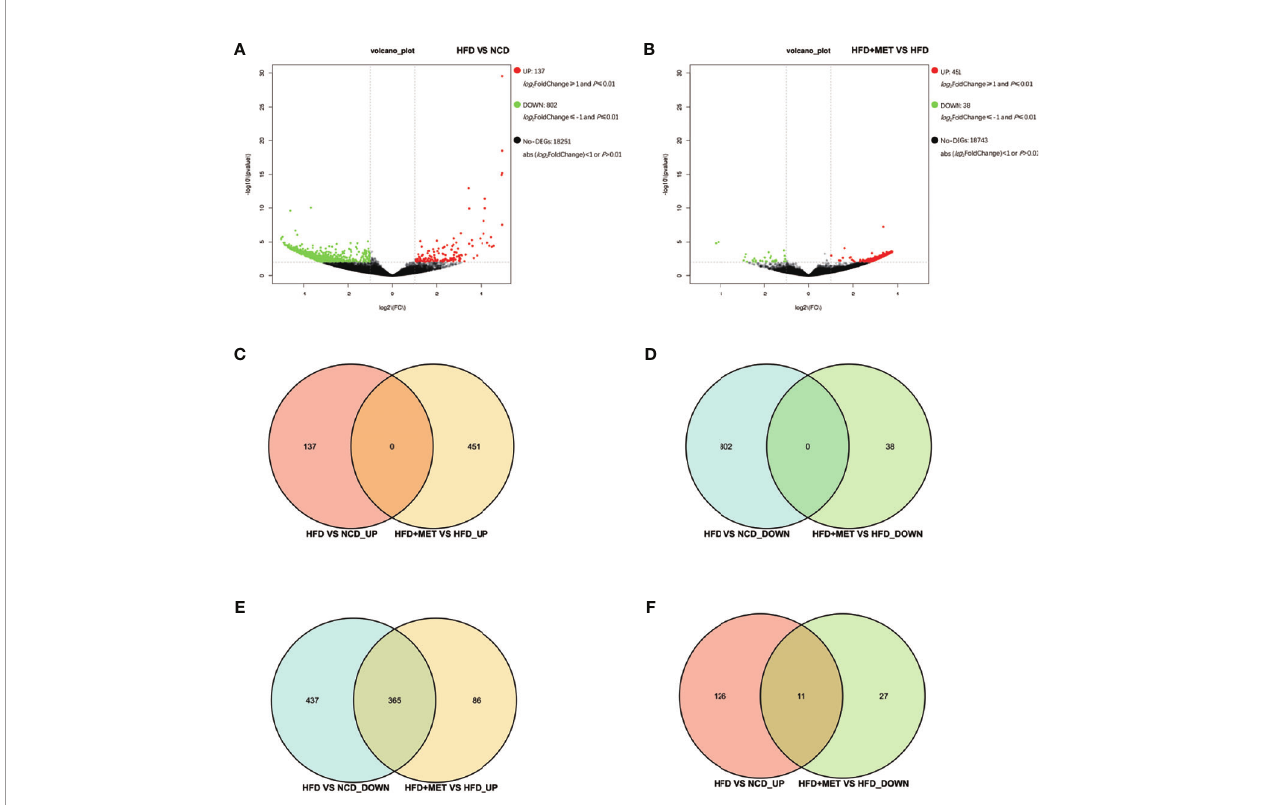
FIGURE 3 | Differentially expressed genes (DEGs) analysis in liver. The volcano plot showed distribution pattern of DEGs in the comparison of HFD vs NCD (A) and HFD+MET vs HFD (B) . Venn diagram of upregulated common DEGs (C) and downregulated common DEGs (D) in two comparisons of HFD vs NCD and HFD+MET vs HFD. Venn diagram of common DEGs showing opposite expression changes in two comparisons of HFD vs NCD and HFD+MET vs HFD (E, F) . Red color or positive number indicates upregulation, and green color or negative number indicates